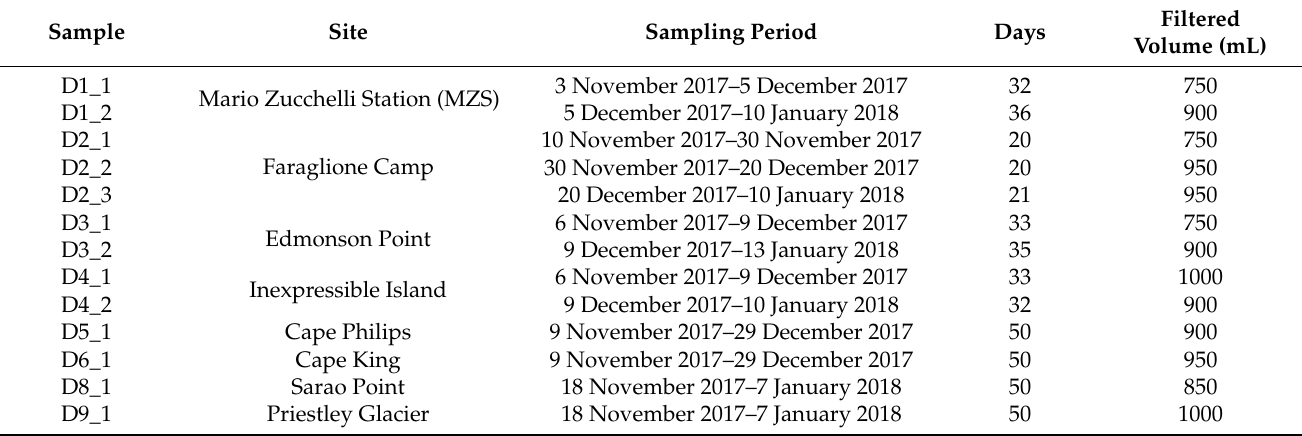
Table 1. Sample sites, sampling periods, sampling duration and samples’ filtered